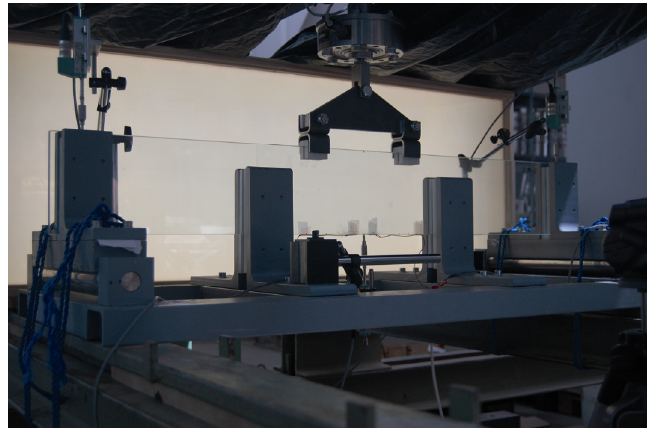
Figure 4: Experimental set-up of short-term